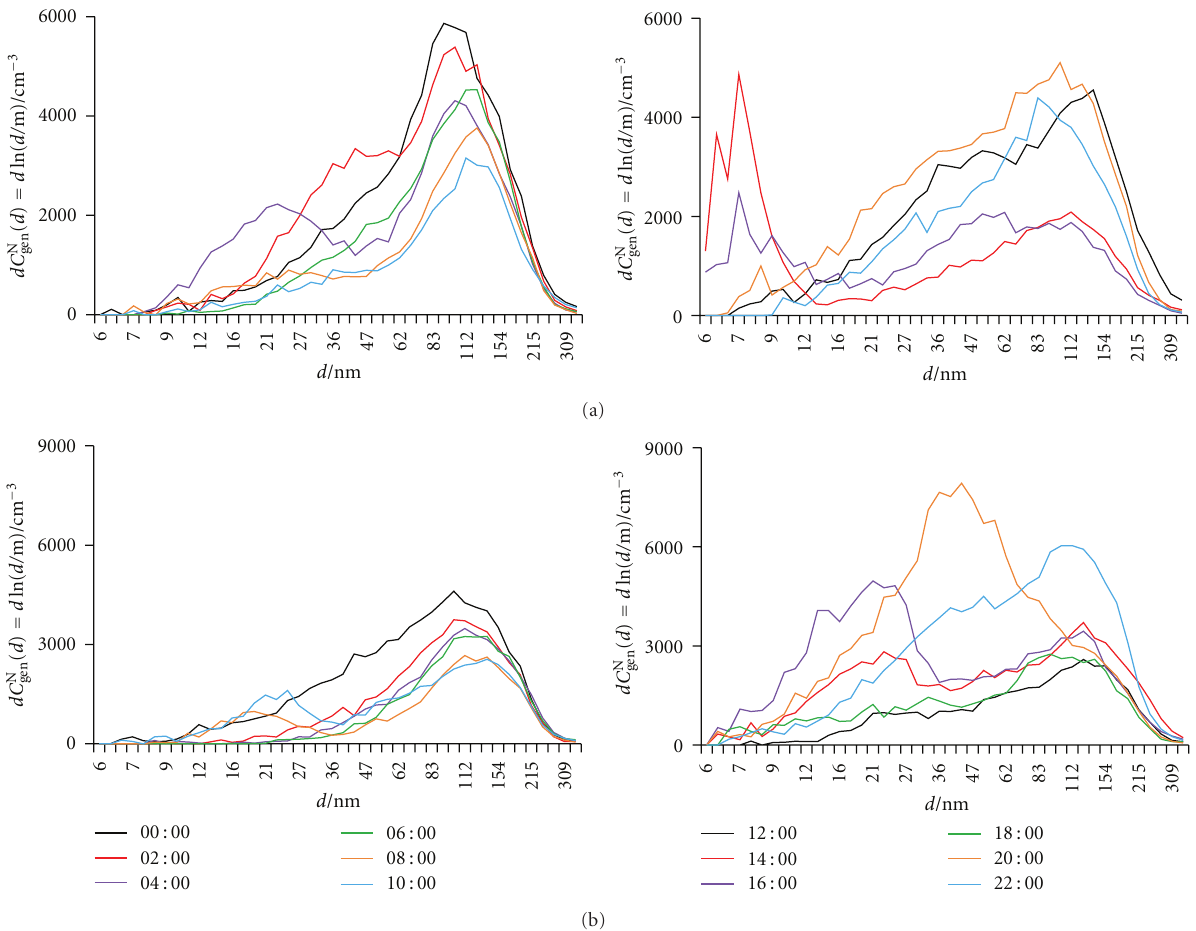
Figure 8: Number particle size distribution (d C N October